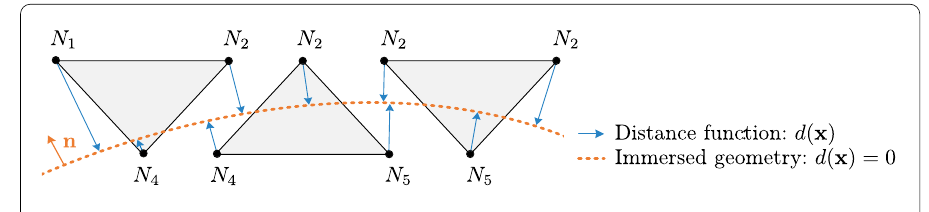
Fig. 3 Element-wise computation of